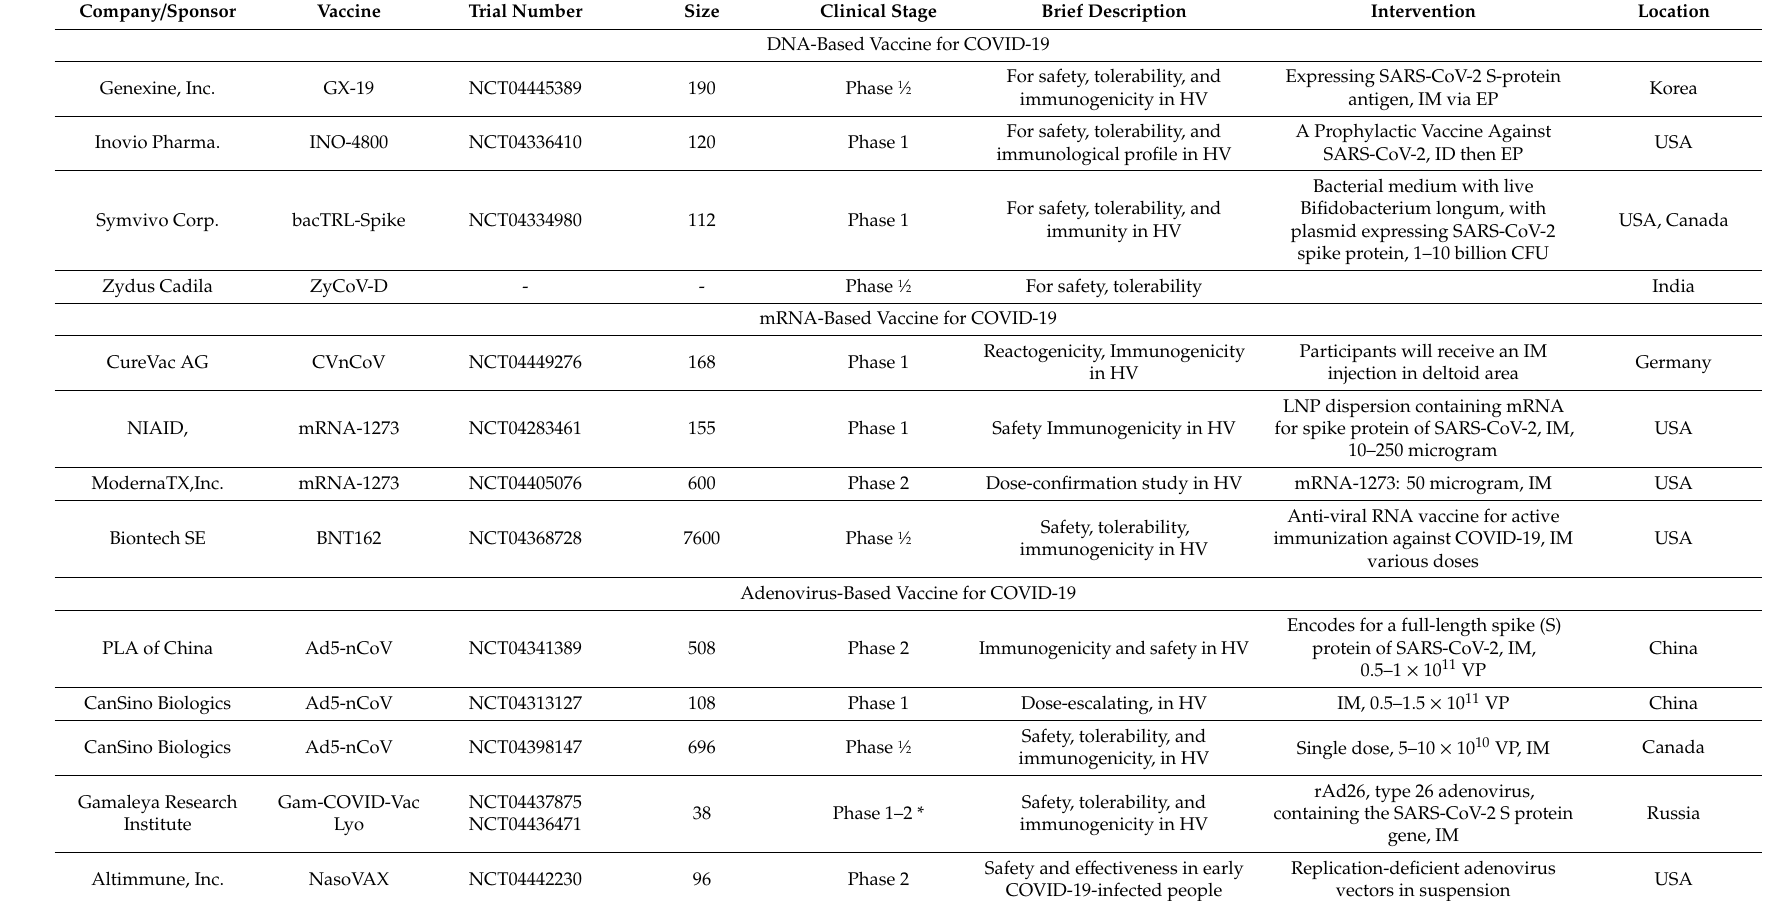
Table 3. Selected list of clinical trials on curated vaccine production platform and respective targets for